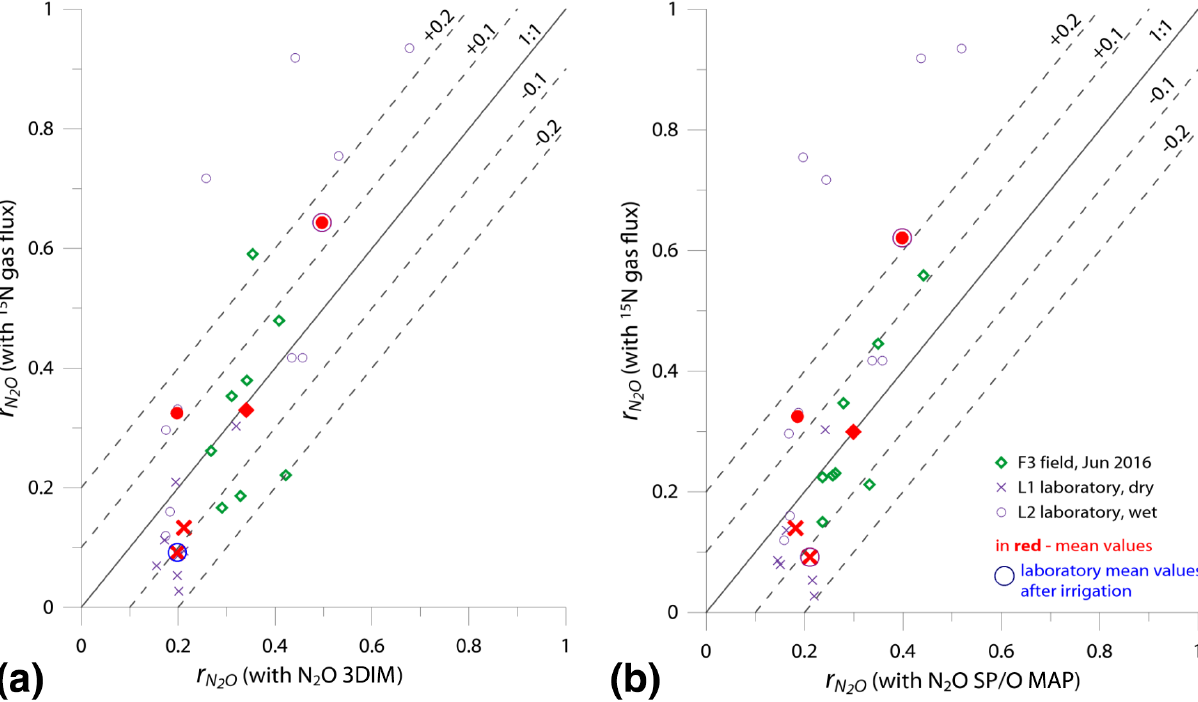
Figure 6. Comparison of 1 : 1 fit between r N MAP Case